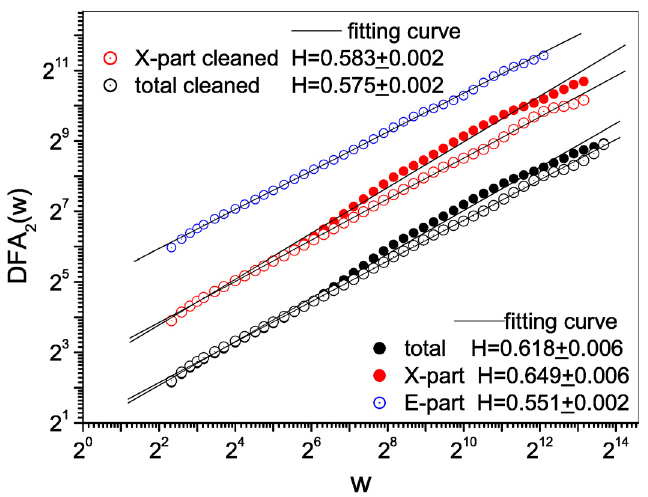
Fig 2. Long-range correlations in the noisy and cleaned series. Noisy records can result in incorrect estimates of the Hurst exponents (solid circles) and consequently false conclusions, even if they only cover a limited proportion of the total series. The effect of noise can be removed using a cleansing procedure (open circles). The X-and E-part of the text are the first to 80th chapters, and the 81th to the 120th chapters, which are currently attributed to Xueqin Cao and E Gao,